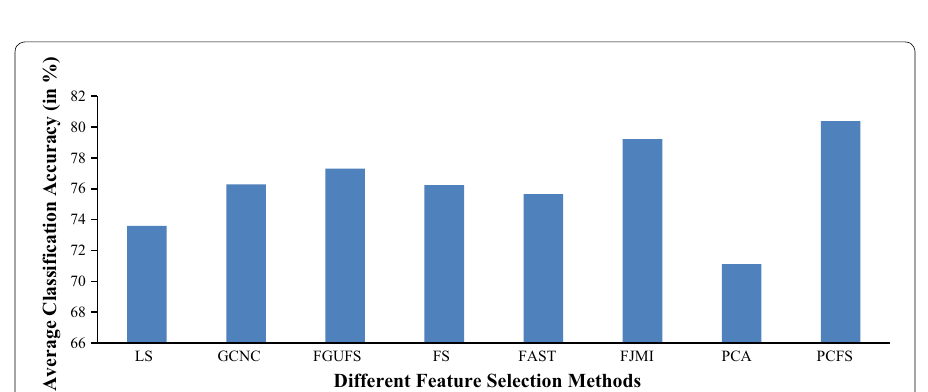
Fig. 2 Average classification accuracy over all datasets on the Naive Bayes